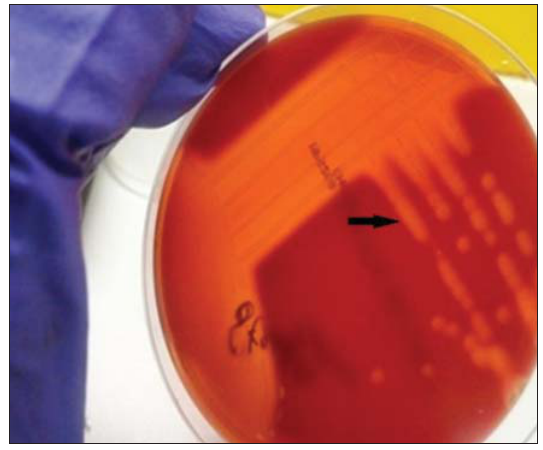
Figure-2: Streptococcus equi showing beta hemolysis on blood